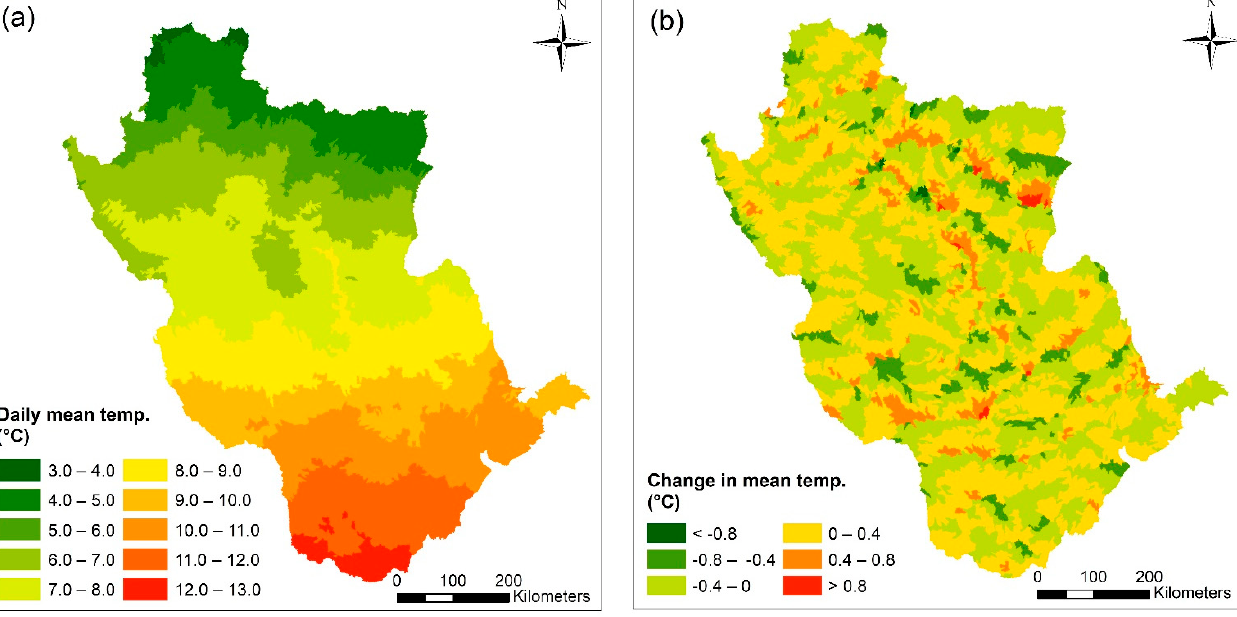
Figure 8. Average daily mean temperature in HUC12 delineation scenarios for ( a ) PRISM data and ( b ) absolute changes from PRISM to PRISM* during 1983 to 2005.